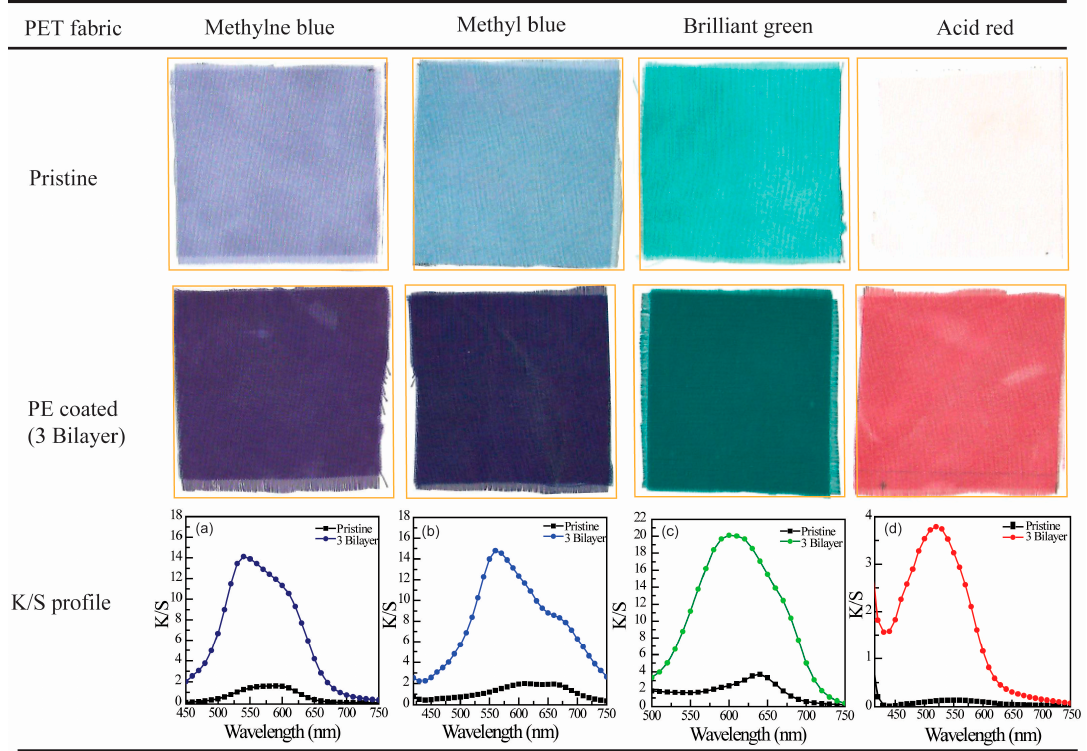
Figure 7. Photographs of pristine PET fabric and (PDADMAC/PAA) 3 -PET fabric dyed with different dyestuff. Profiles from ( a ) to ( d ) are the corresponding K/S profiles of each dyed PET fabrics.